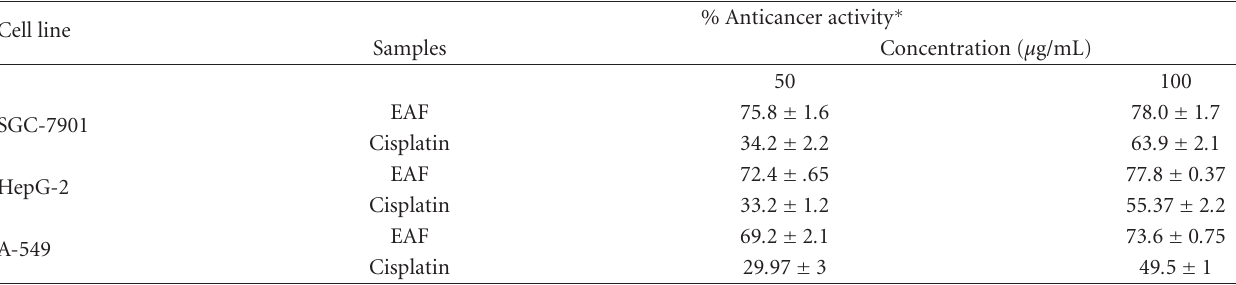
Values are mean ± standard deviation of three replicate analyses. CF, Crude ethanol fraction; HF, Hexane fraction; EAF, Ethyl acetate fraction; BF, Butanol fraction; WF, Water fraction. For each treatment, the means in a column followed by di ff erent letters were significantly di ff erent at P < . 05. Table 2: Anticancer activities of the ethyl acetate fraction of wampee fruit pericarp and cisplatin. Cell